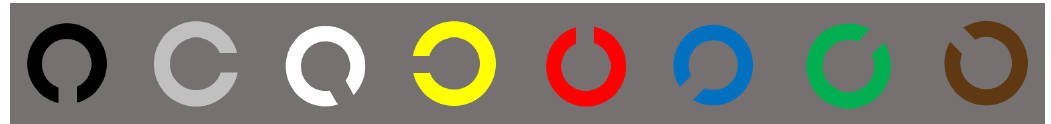
Figure 5. Targets used in experiment with different colors.